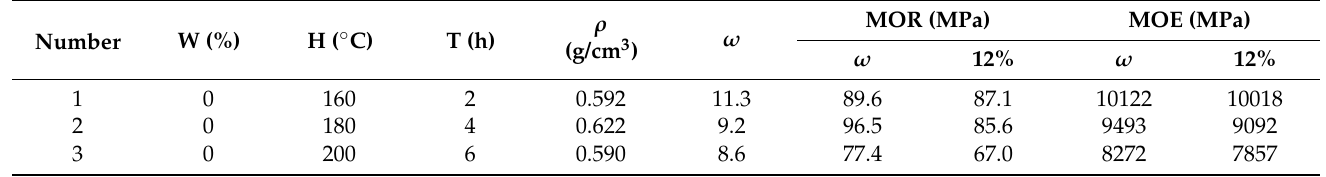
Table 17. Orthogonal analysis of MOR and MOE of impregnated heat-treated